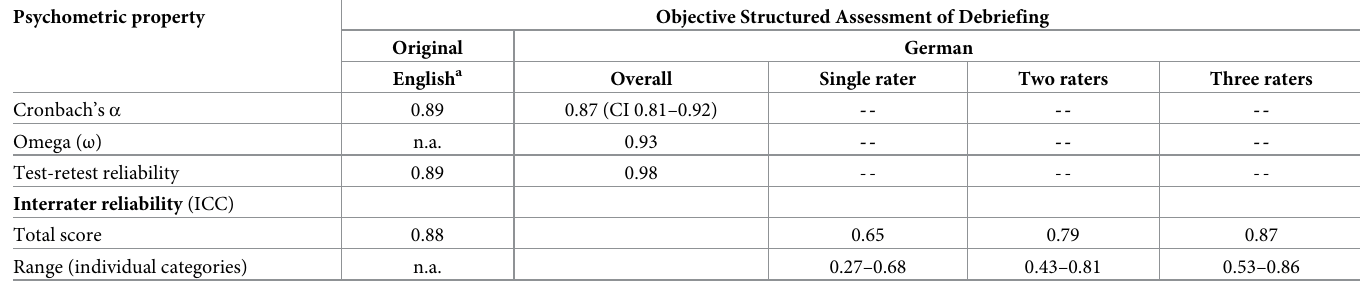
Table 3. Psychometric properties of the original English Objective Structured Assessment of Debriefing (OSAD) [17] and the German OSAD. Psychometric